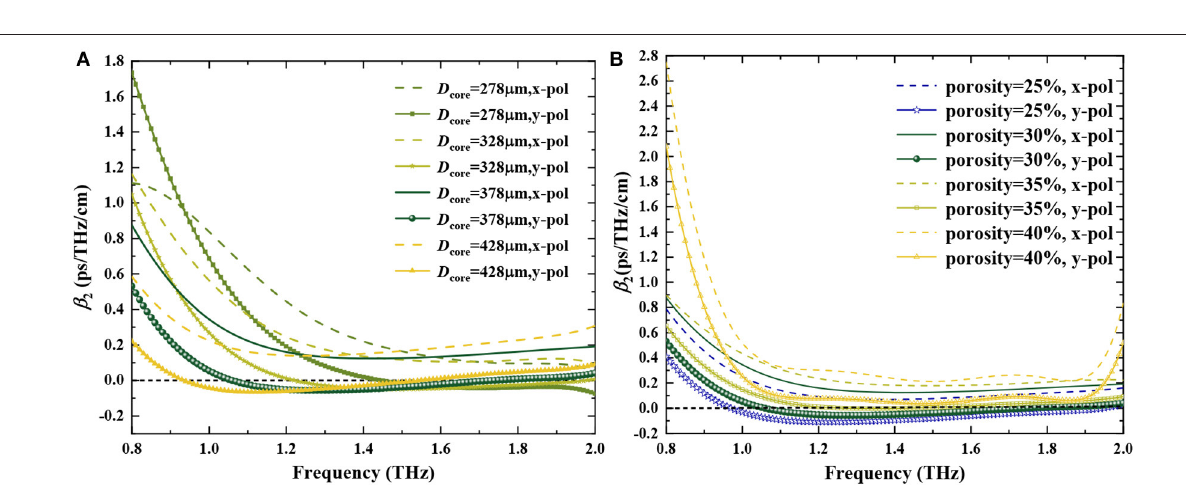
FIGURE 5 | Dispersion vs. frequency of the proposed PCF (A) for different D core at P = 30%, (B) for different core porosity at D core = 378 µ